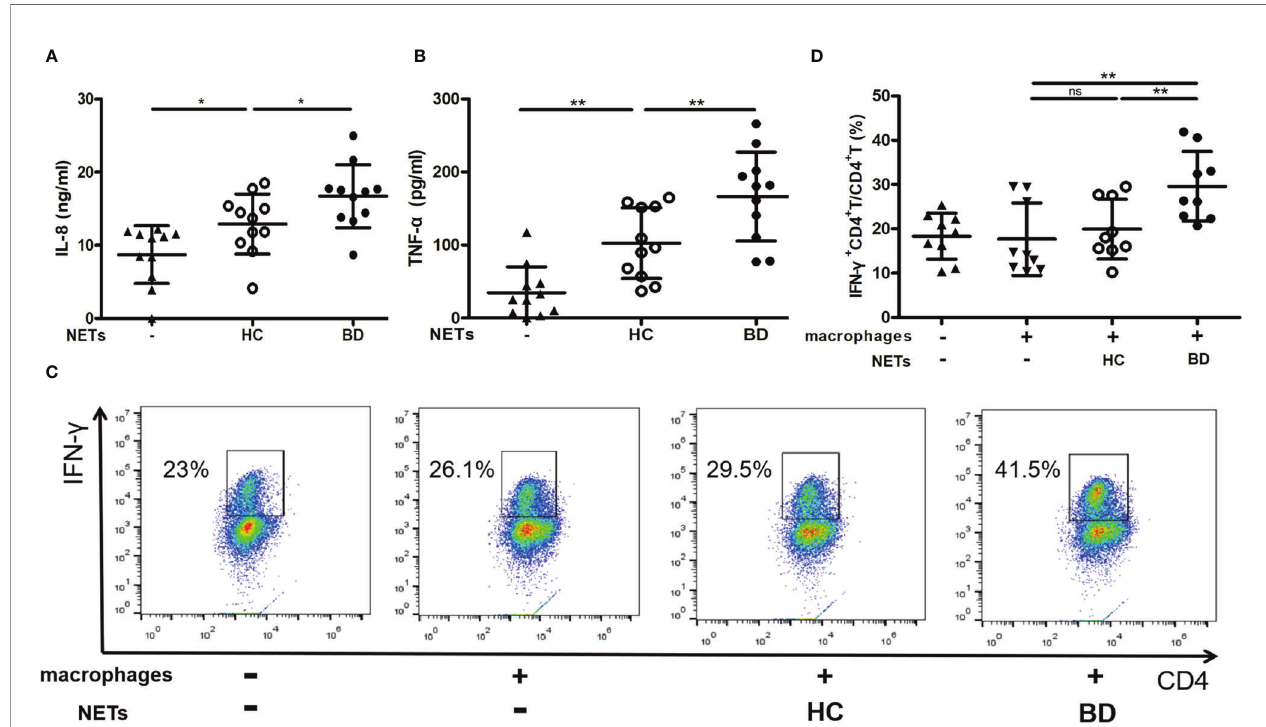
FIGURE 2 | BD neutrophil extracellular traps (NETs) promote macrophages activation. Macrophages were stimulated with HC NETs (n = 11) or BD NETs (n = 11) for 24 h, and (A) IL-8 and (B) TNF- a production were measured using ELISA. NETs-stimulated or untreated macrophages were incubated with naive CD4 + T cells for 5 days, and (C, D) IFN- g + CD4 + T cells (n = 9) were measured by fl ow cytometry. Bars indicate mean value and Standard Deviation. One-way ANOVA with LSD for post-hoc test was applied. *p < 0.05, **p < 0.01. BD, Behc ̧ et ’ s disease; HC, healthy controls. ns, not signi fi